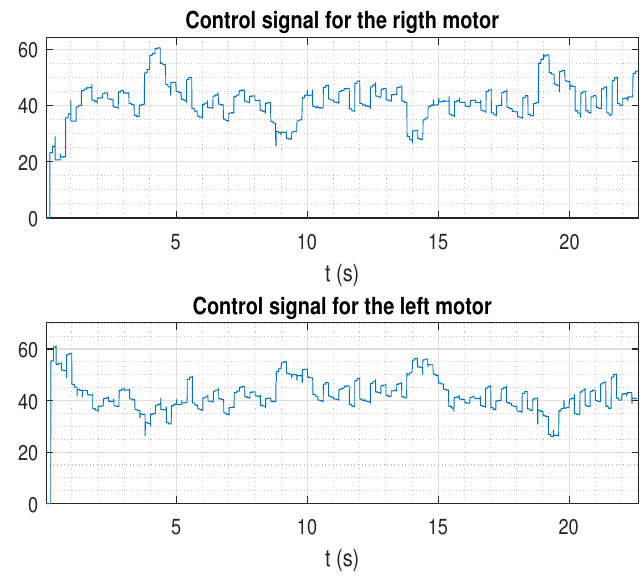
Figure 12. Control signal for the control proposal (EKF, prediction stage, and packet-based control) with delays and a higher level of